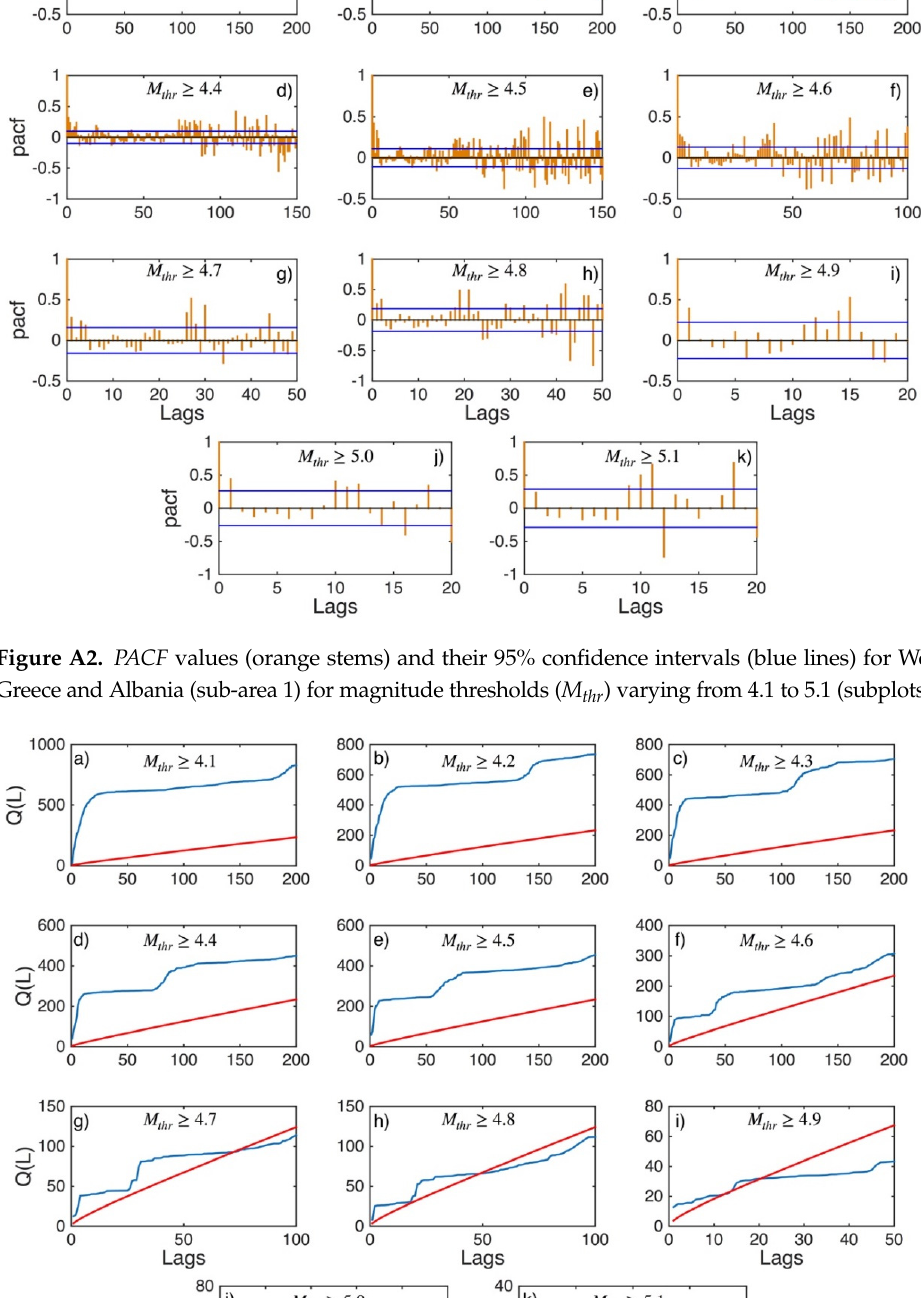
Figure A4. ACF values (red stems) and their 95% confidence intervals (blue lines) for Western Hellenic Arc (sub − area 3) for magnitude thresholds ( M thr ) varying from 4.1 to 4.8 (subplots a – h ).